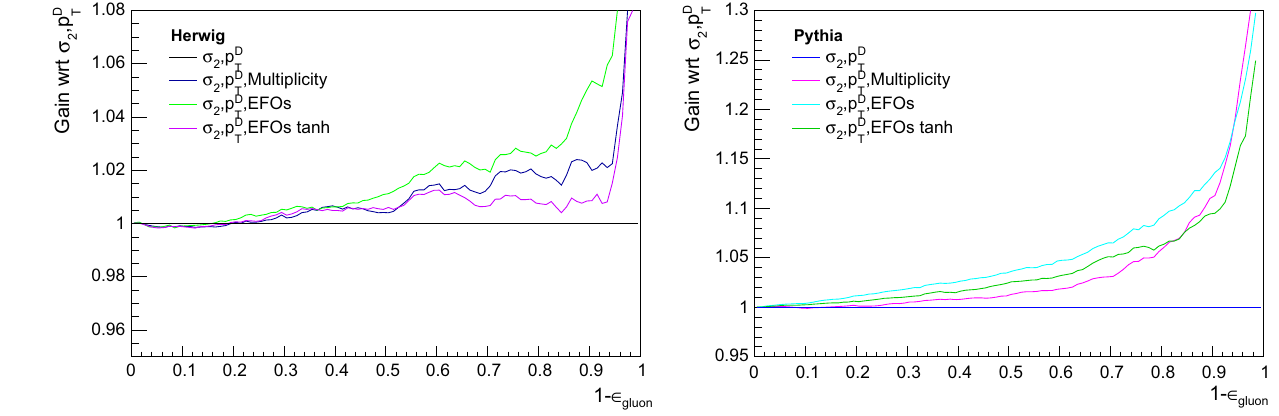
specified in Sect. 2.1, for which the performance is worse. Right: for Pythia events. Note the wider range of the y-axis, to accommodate the larger gains found in Pythia